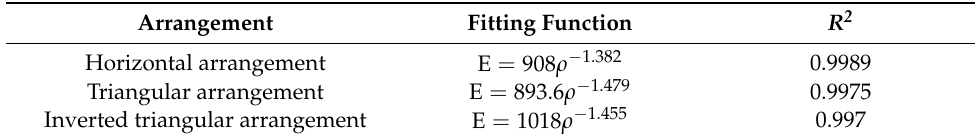
Table 2. Fitting function and 𝑅 2 results.